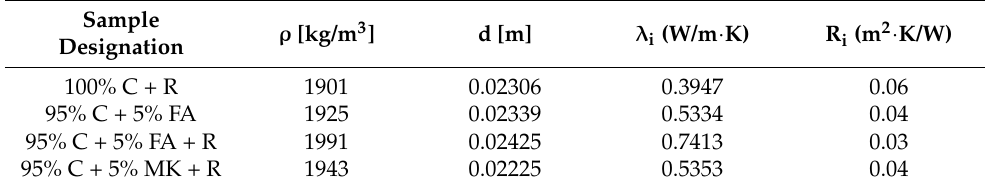
Table 4. Thermal conductivity and thermal resistance of concrete and concrete–geopolymer hy- brid